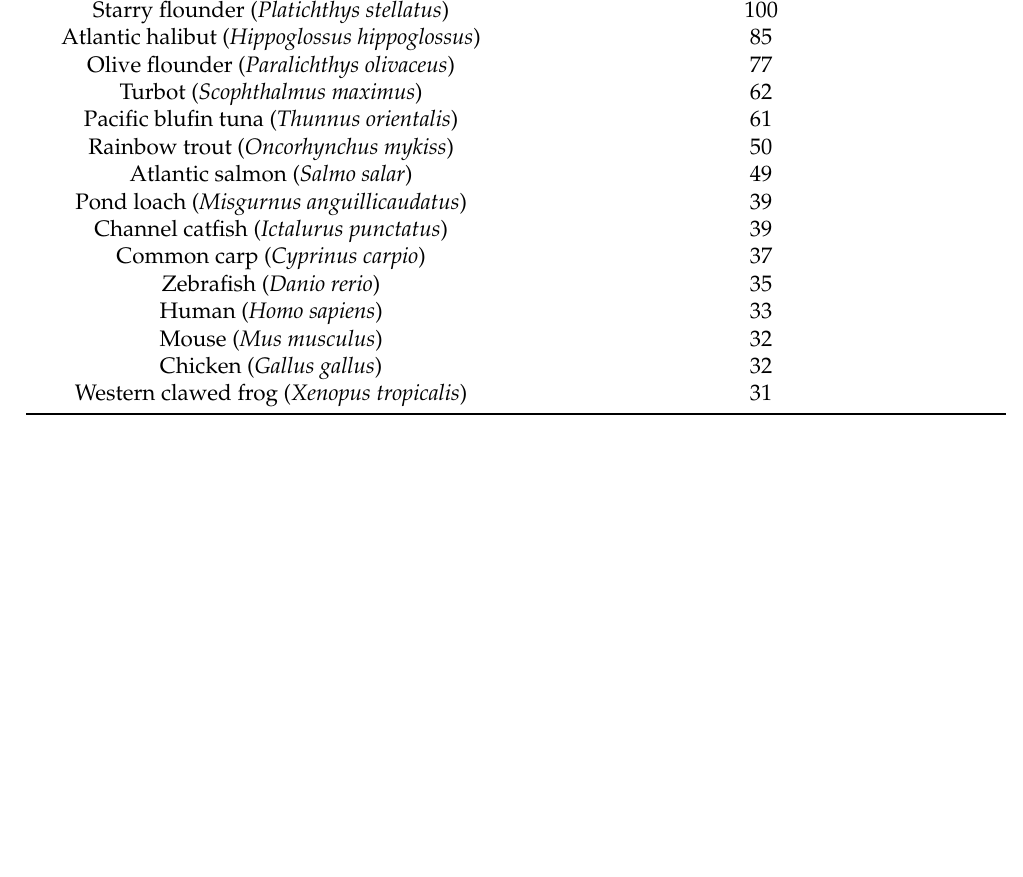
Table 2. Sequence identities comparing psdnd to homologues in other species.